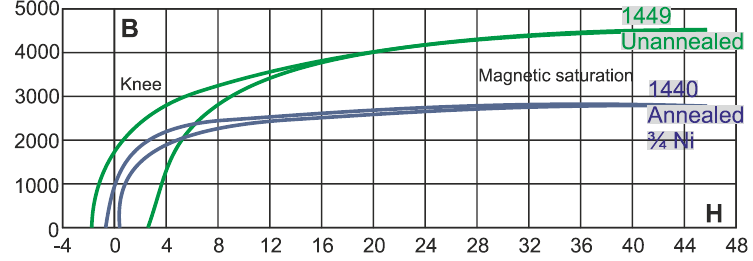
Figure 10. B-H curve in high nickel steel (adapted from